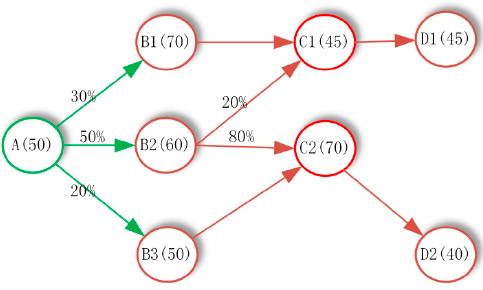
Figure 5. Multi-path energy consumption.